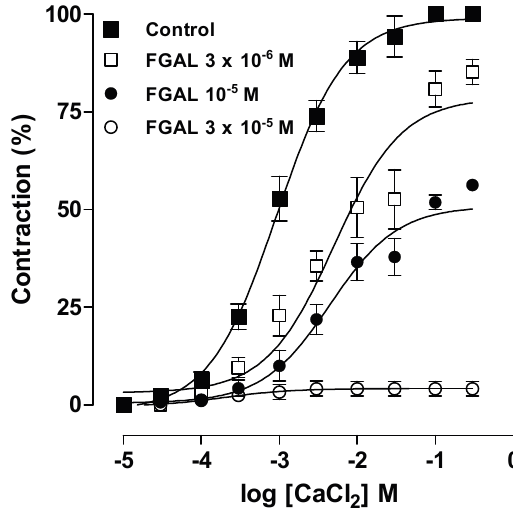
Figure 7. Cumulative concentration-response curves to CaCl 2 in the presence of verapamil (10 − 6 M) and Phe (10 − 6 M), in both the absence ( ■ , control, n = 5) and presence of 3 × 10 − 6 ( □ , n = 5), 10 − 5 ( ● , n = 5) and 3 × 10 − 5 M ( ○ , n = 5) of FGAL. Symbols and vertical bars represent the mean and S.E.M.,